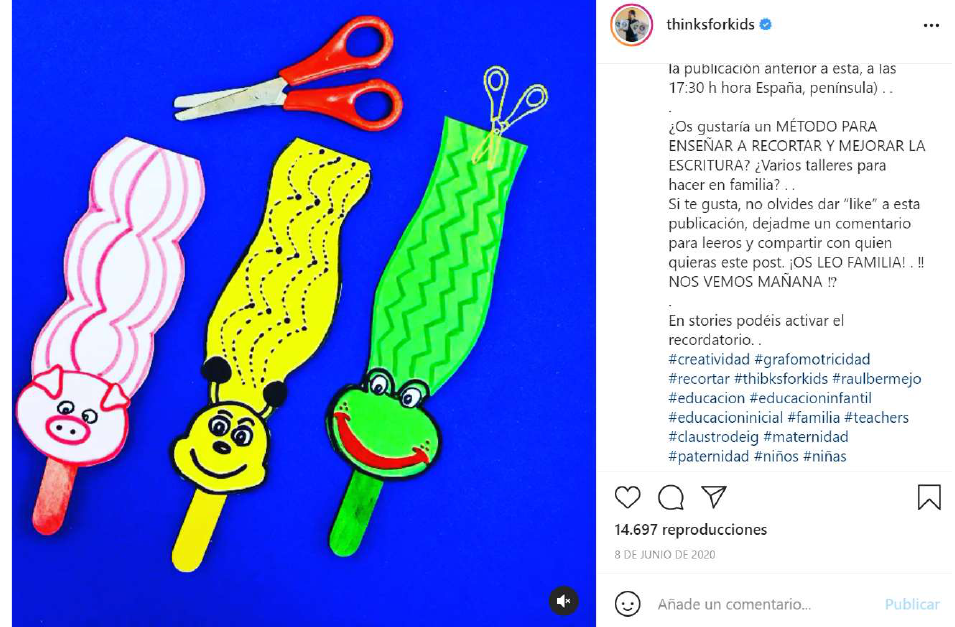
Figure 8. Example of the use of text in publications. In this case @thinksforkids interacts with his followers, asking about the content of the channel, and asking for likes on the publication Source: @thinksforkids.